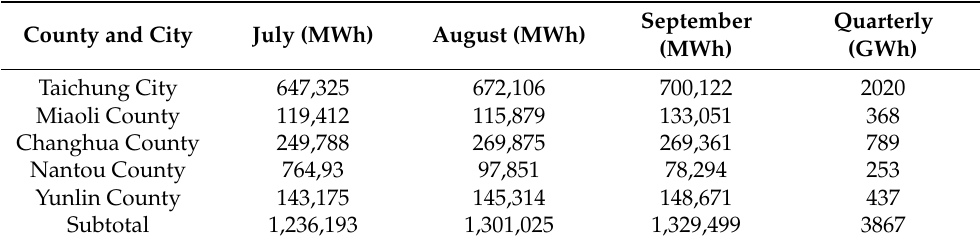
Table 7. Electricity consumption in the third quarter of 2020 by residential sector in central Tai- wan household.